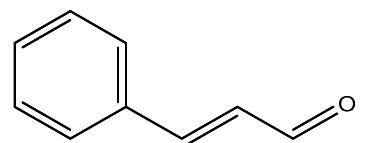
Figure 3. Chemical structure of cinnamaldehyde.